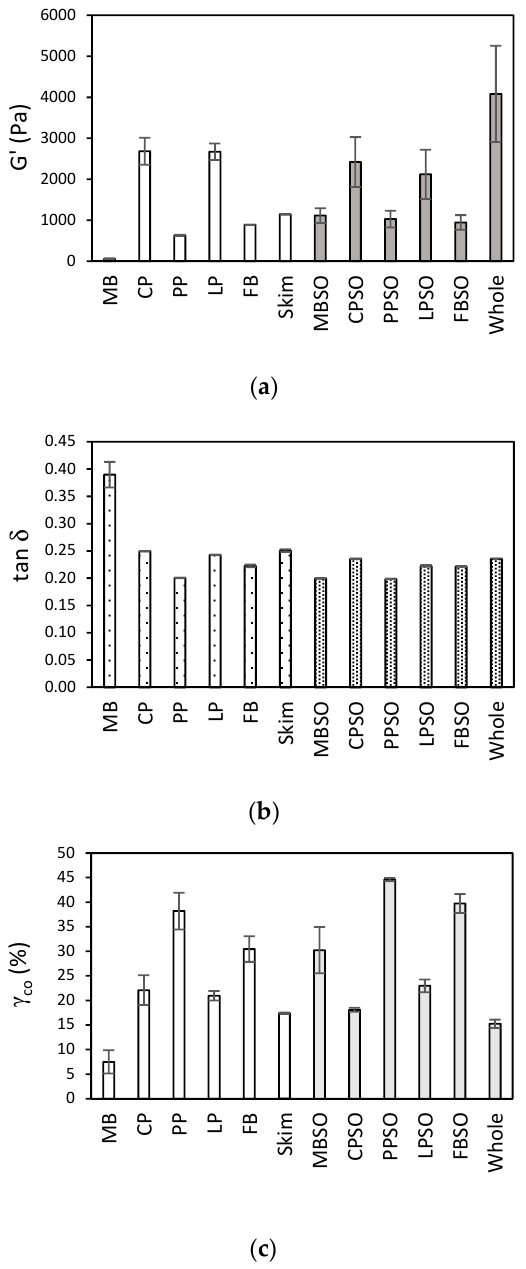
Figure 2. Rheological parameters obtained from amplitude sweeps of high pressure-treated 12% ( w / w ) mung bean (MB), chickpea (CP), pea (PP), lentil (LP), and faba bean (FB) protein samples without and with 5% ( w / w ) sunflower oil (SO) as compared to commercial plain skim and whole milk Greek yogurt. ( a ) Storage modulus (G’) at 0.1% strain; ( b ) loss tangent (tan δ ) at 0.1% strain; ( c ) crossover strain ( γ co ) when G’ = G’’. The average of two treatments is presented with the error bar extremes showing the data for each treatment.